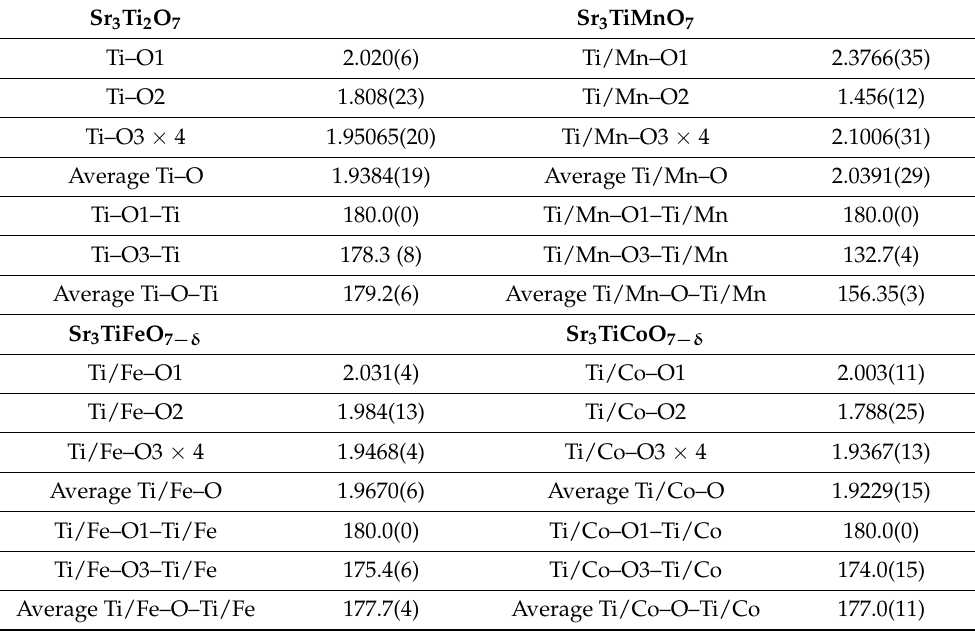
Table 5. B-O bond distances and B-O-B angles for the synthesized